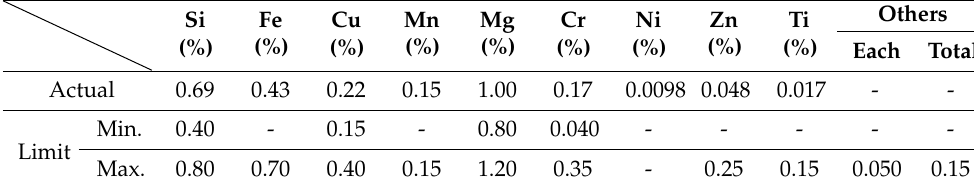
Table 6. Chemical composition of Al 6061 T6.